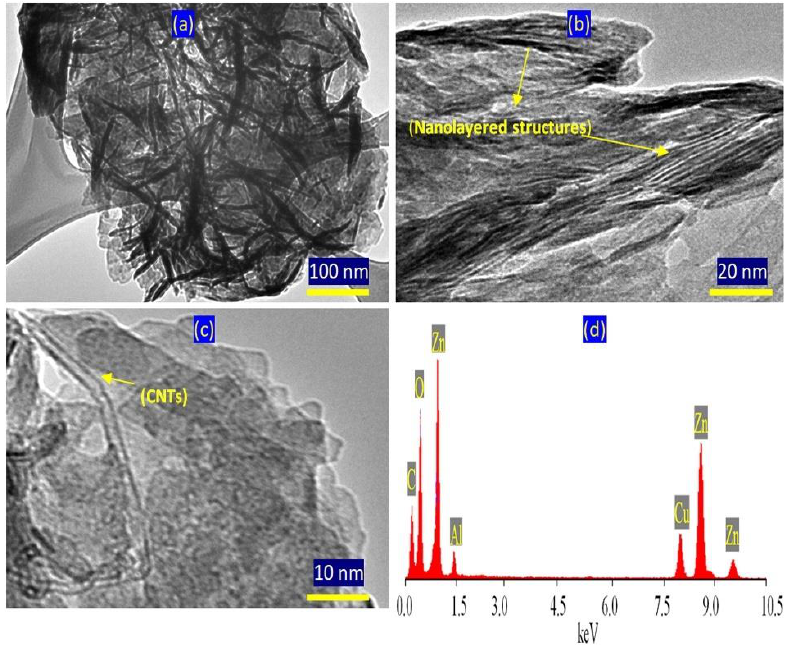
Figure 9. TEM images of AZ-3: ( a ) at 100 nm, ( b ) at 20 nm, ( c ) at 10 nm and ( d ) in the EDX spec- trum.